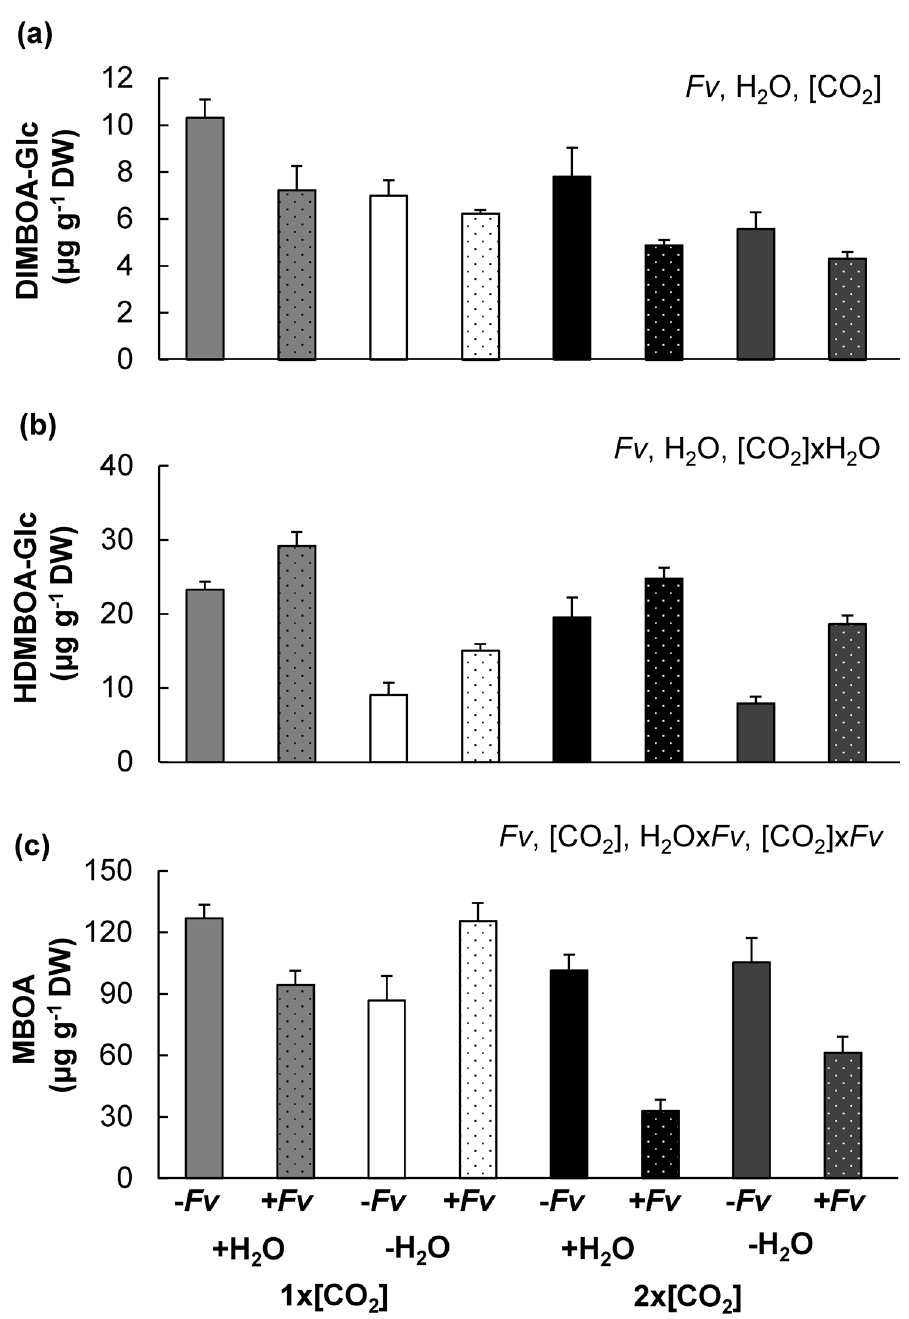
Fig 7. Effects of 2x[CO 2 ] and drought ( – H 2 O) on maize benzoxazinoid defense metabolites. The mean ± SEM concentration of (a) DIMBOA-Glc, (a) HDMBOA-Glc and the downstream degradation product of their aglycones, (c) MBOA was determined for both mock (- Fv ) or F . verticillioides (+ Fv ) inoculated stem tissues. Individual and interacting factors significantly contributing to differences are indicated at the top right corner of each graph (2x2x2 ([CO 2 ]xH 2 Ox Fv ) ANOVA, n = 4, P < 0.05).